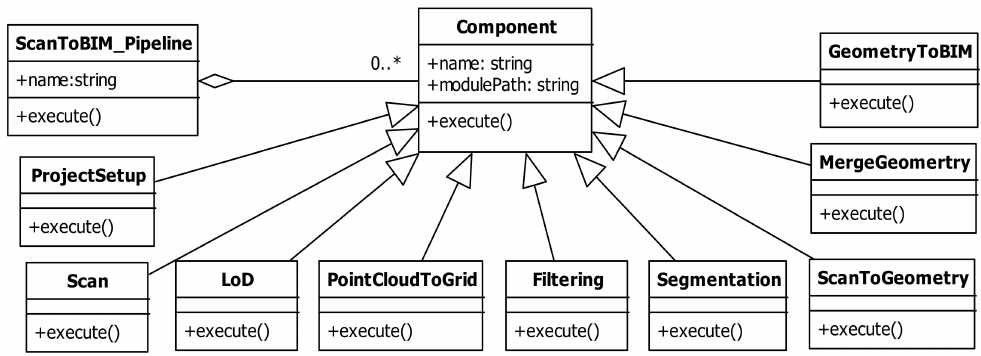
Figure 7. Scan-to-BIM Pipeline Architecture